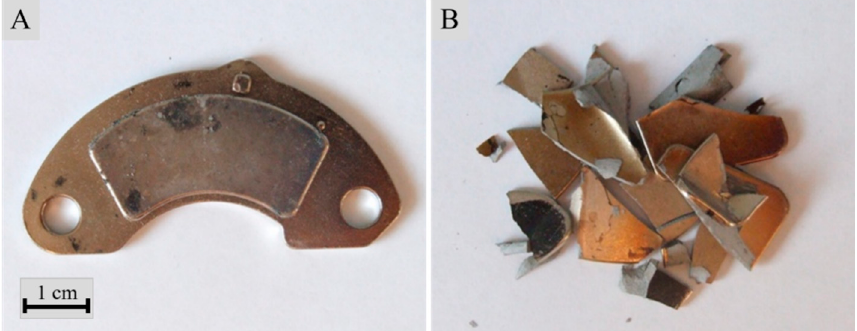
Figure 2. The whole magnet without demagnetization, glued to a steel plate ( A ); pieces of demag- netized and broken magnets ( B ). tized and broken magnets ( B